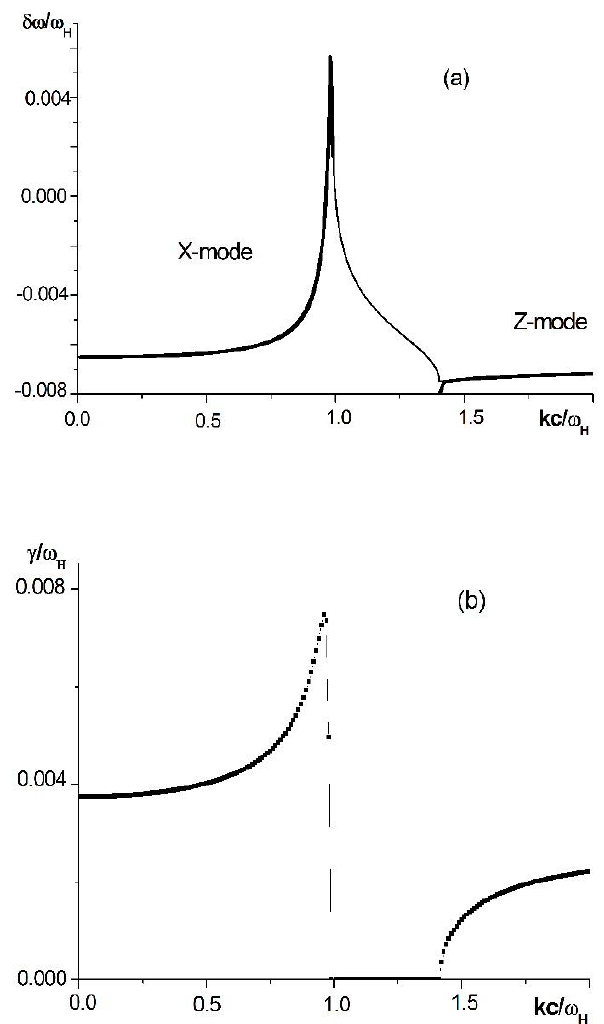
Fig. 5. The dispersion relations for the perpendicular propagation in the homogeneous plasma for a ring distribution with the same parameters as have been taken at the center of the model source. (a) δω = (ω − ω H ) and (b) growth rates versus the dimensionless wave number.